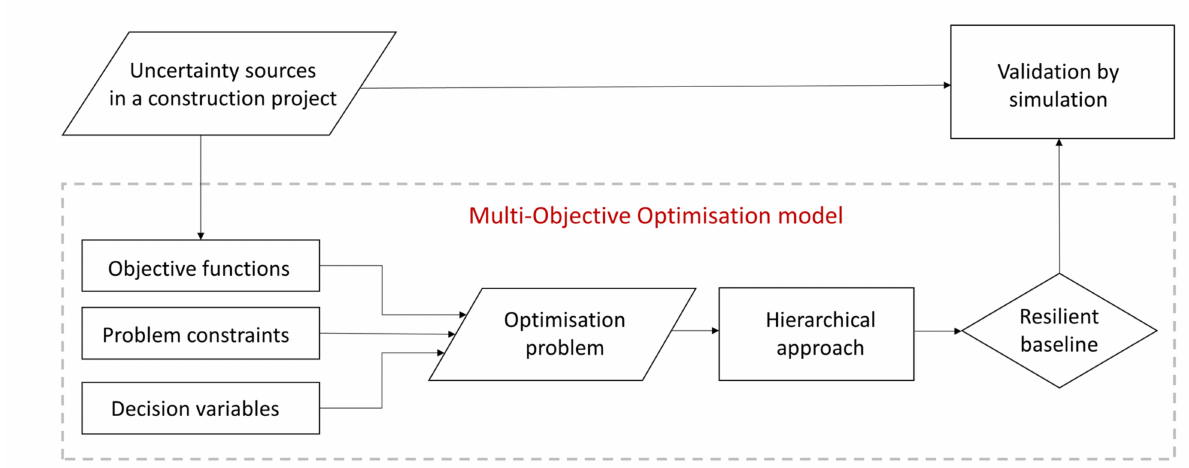
Figure 1. Algorithm for the resilience approach to manage